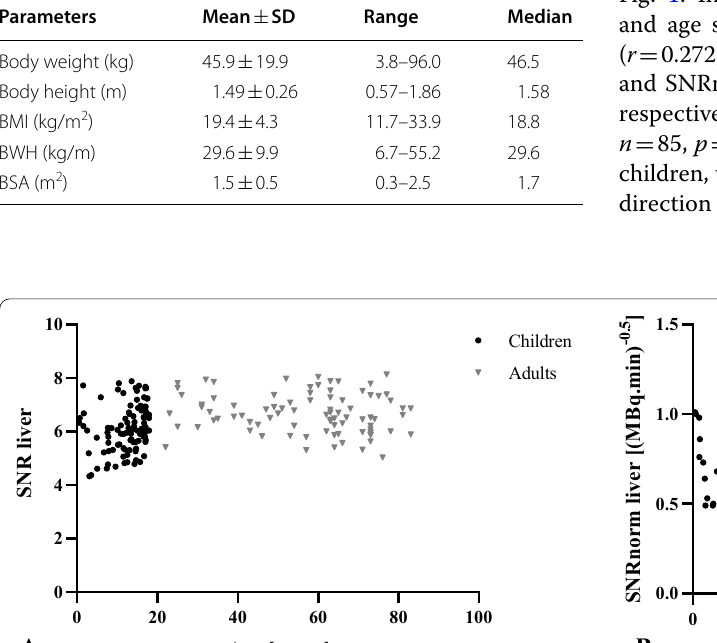
Table 1 Paediatric patient-dependent parameters and SUV values Parameters